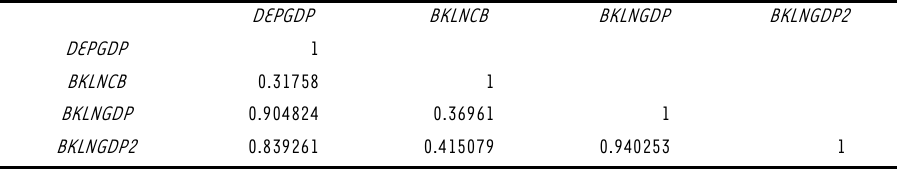
Financial development correlation matrix